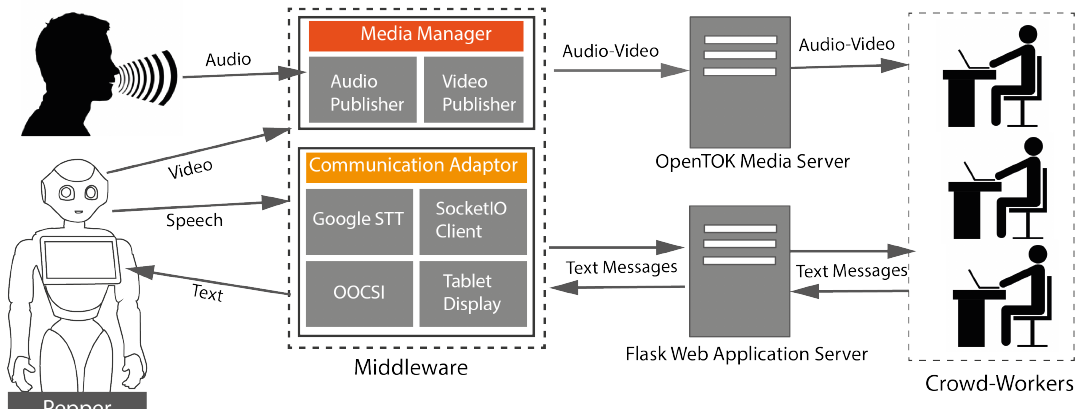
Figure 1. High-level system architecture of Crowd of